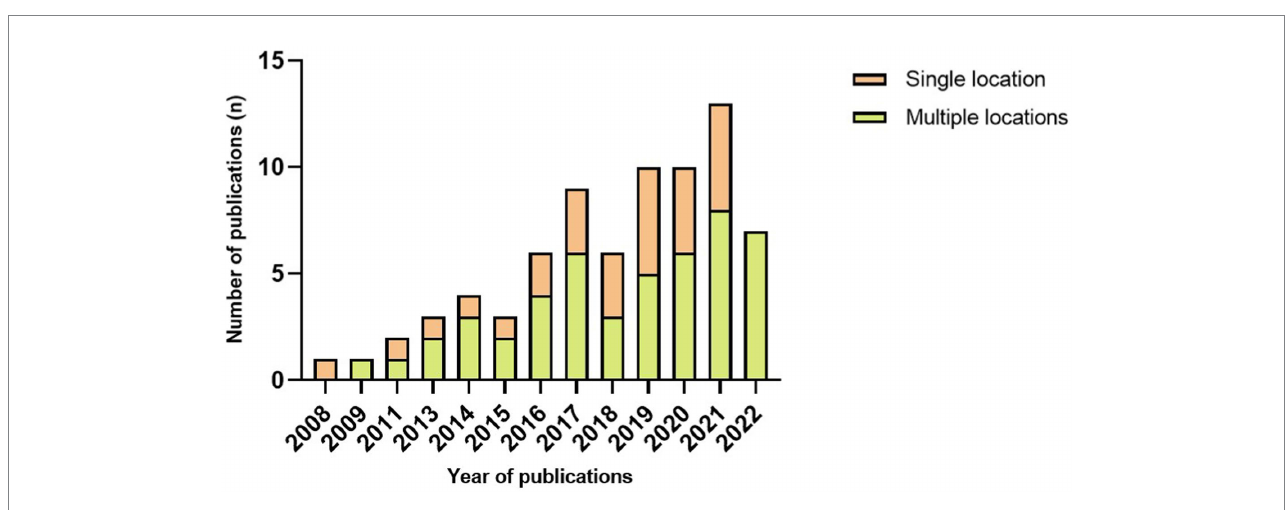
FIGURE 3 Number of publications each year per number of sensor